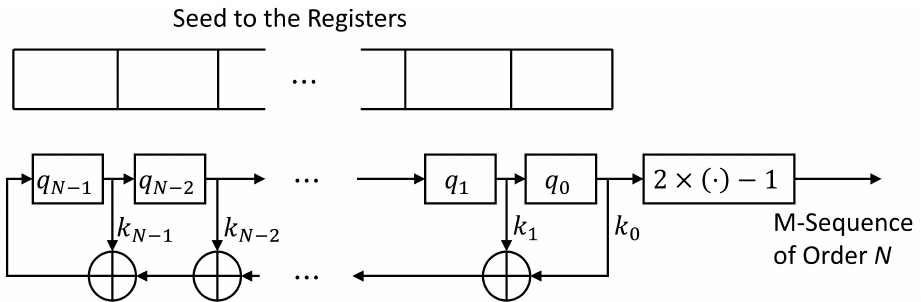
Figure 4. Structure of the Feedback Shift-Registers to Generate the M-Sequences.